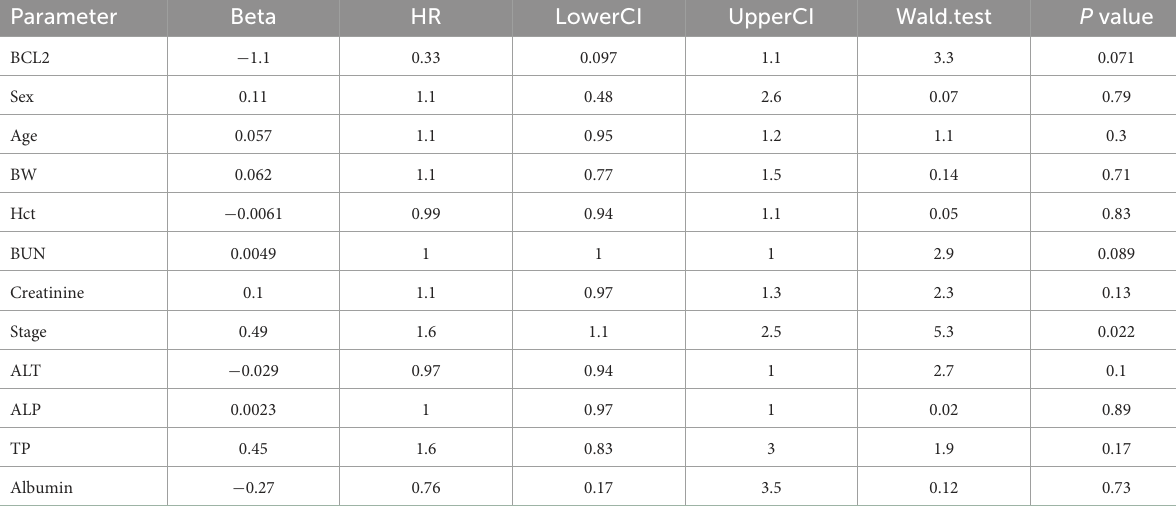
TABLE 2 The parameters that are associated with CKD progression (hazard ratio > 1). Parameter